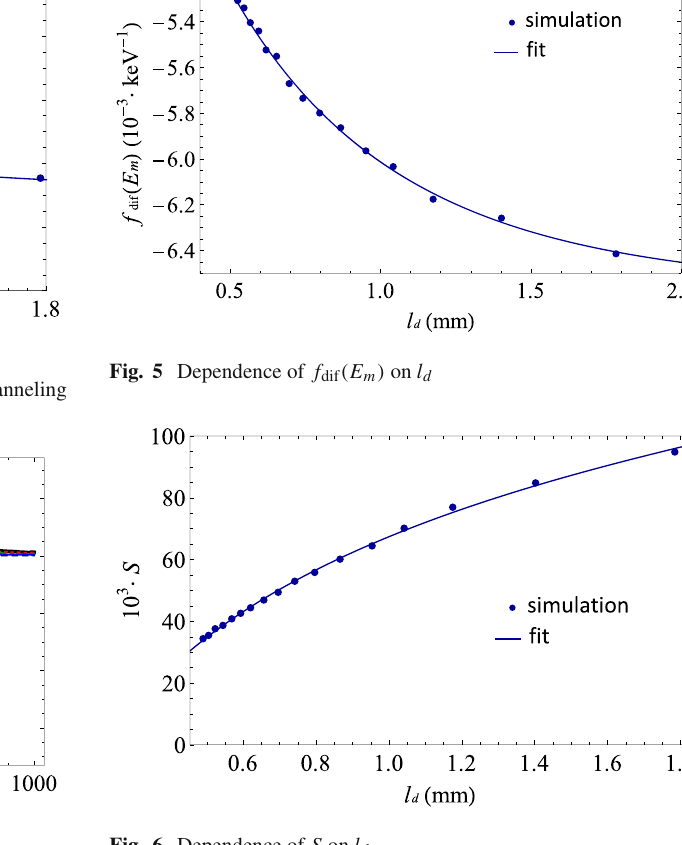
Fig. 4 Difference of the spectra presented in Figs. 2 and 1